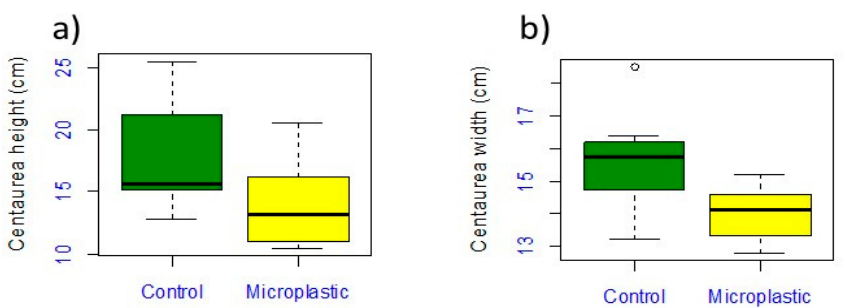
Figure 3. Plant height ( a ) and width ( b ) of C. cyanus in control and microplastic treatment.